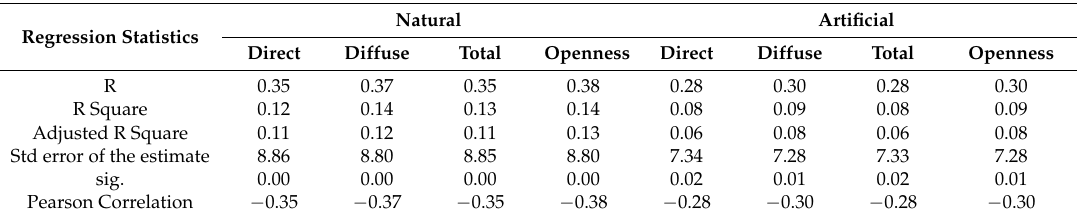
Table 3. Statistical summary table for the number/amount of natural and artificial regeneration as dependent variables.